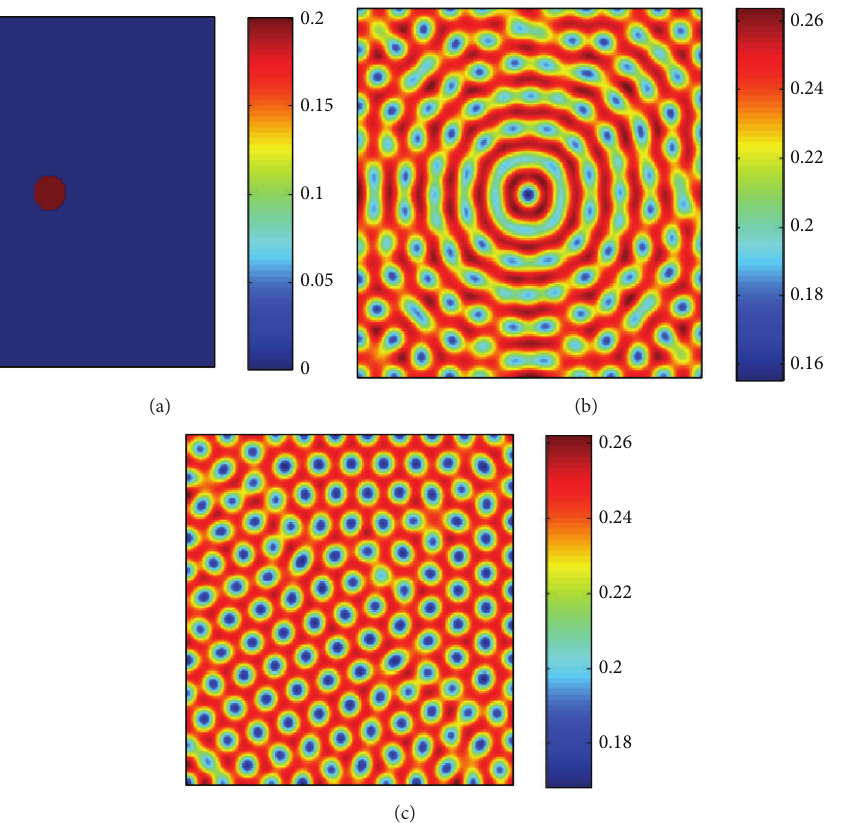
Figure 12: Snapshots of contour pictures of the time evolution of predator in system (3) with the initial condition (29) when 𝑑 2 = 7 and 𝛿 = 0.6 : (a) 0 iteration, (b) 100000 iterations, and (c) 1000000 iterations.